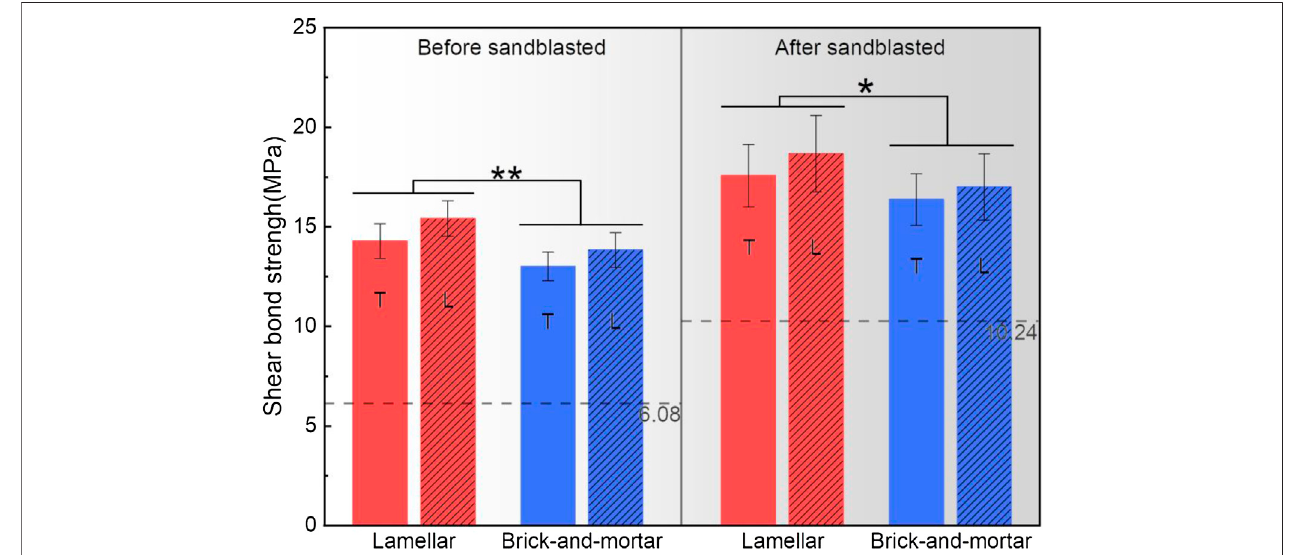
FIGURE 5 | Graphical representation of mean shear bonding strength values (±SD) of all groups. The dashed line represents the bonding strength of the control group (Vita In-Ceram YZ) *: statistically signi fi cant differences ( n = 12, p < 0.05 ).